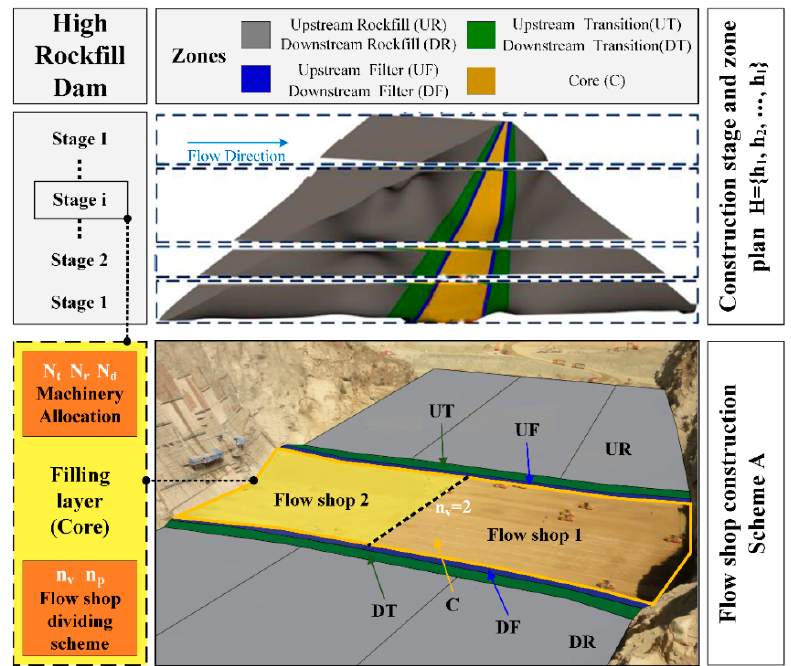
Figure 2. Research framework.